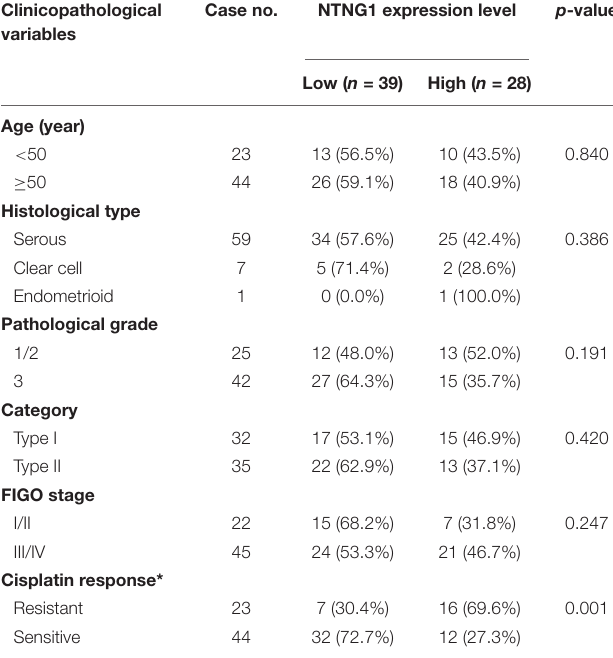
TABLE 1 | Clinicopathological characteristics and their associations with the expression level of NTNG1 in ovarian cancer tissues. Clinicopathological